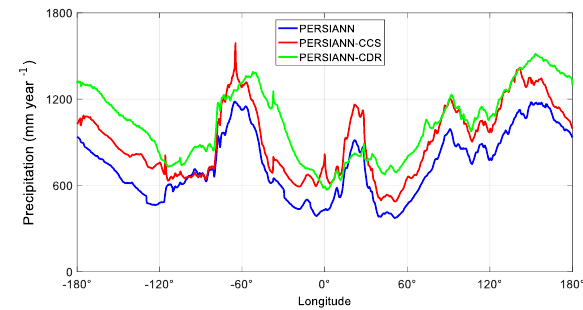
Figure 6. Mean annual precipitation (mm) for PERSIANN, PERSIANN-CCS, and PERSIANN-CDR.